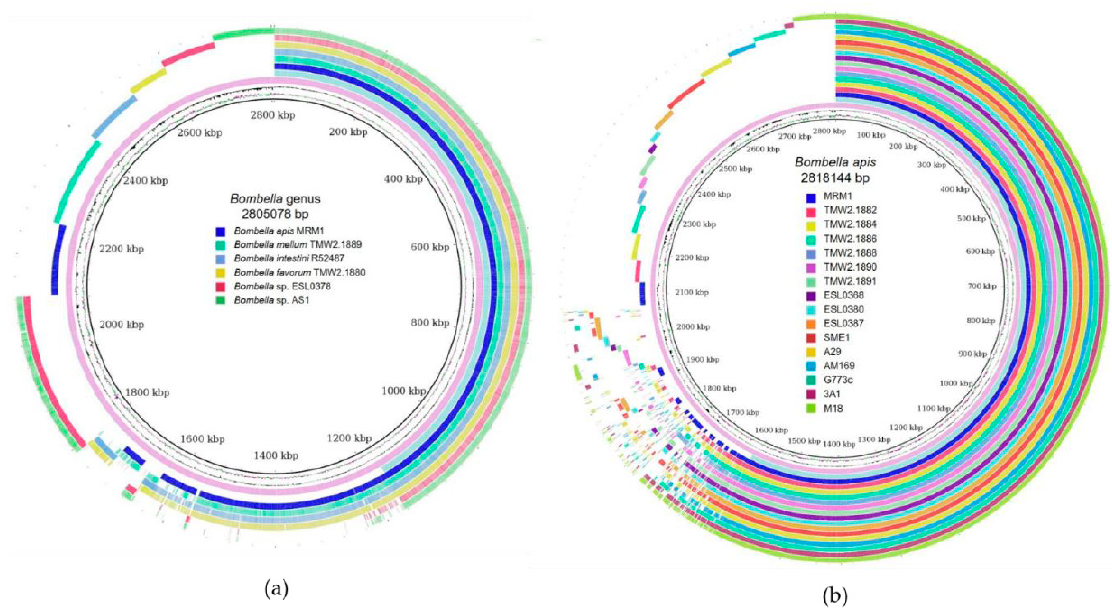
Figure 2. BRIG output image based on the nucleotide sequences of ( a ) Bombella species and ( b ) Bombella apis strains.